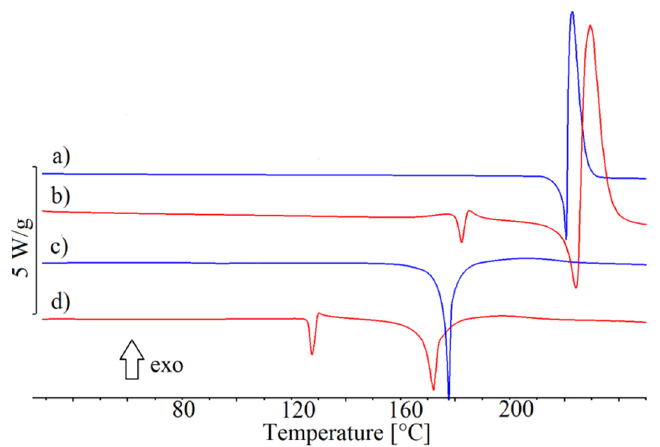
Figure 2. DSC curves of: ( a ) chlordiazepoxide co-crystals with p -aminobenzoic acid prepared by slurry evaporation method with ethyl acetate as a solvent, ( b ) physical mixture of chlordiazepoxide with p -aminobenzoic acid, ( c ) lorazepam co-crystals with nicotinamide prepared by liquid-assisted grinding method using methanol as a solvent, and ( d ) physical mixture of lorazepam with nicotinamide.